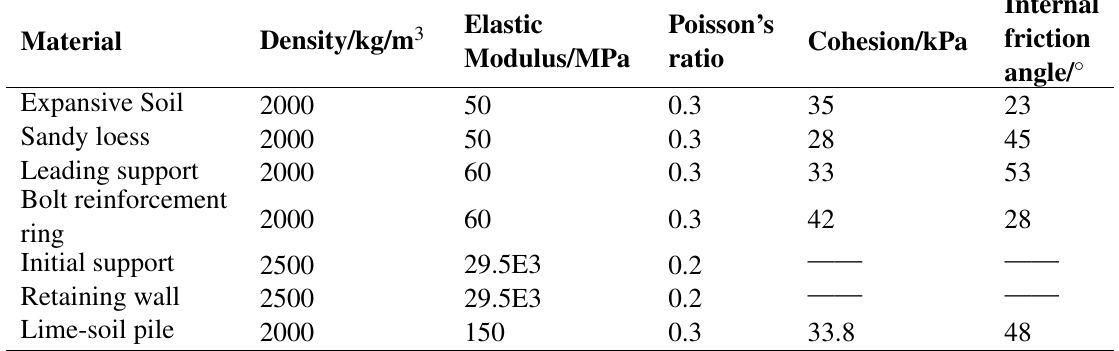
Table 1 Model calculation of mechanical